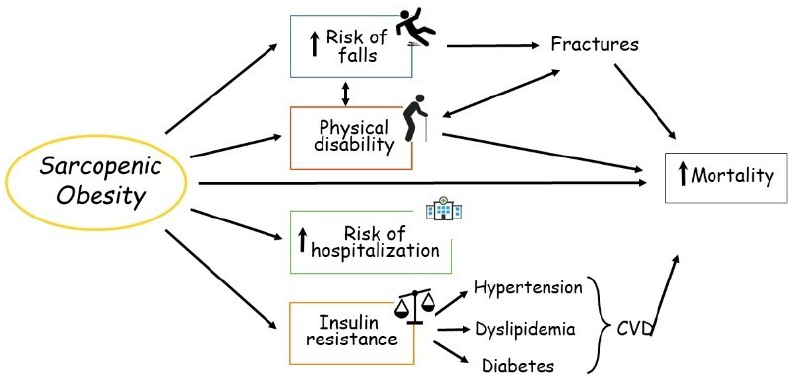
Figure 1. Main consequences of sarcopenic obesity in the elderly. CVD, cardiovascular disease.